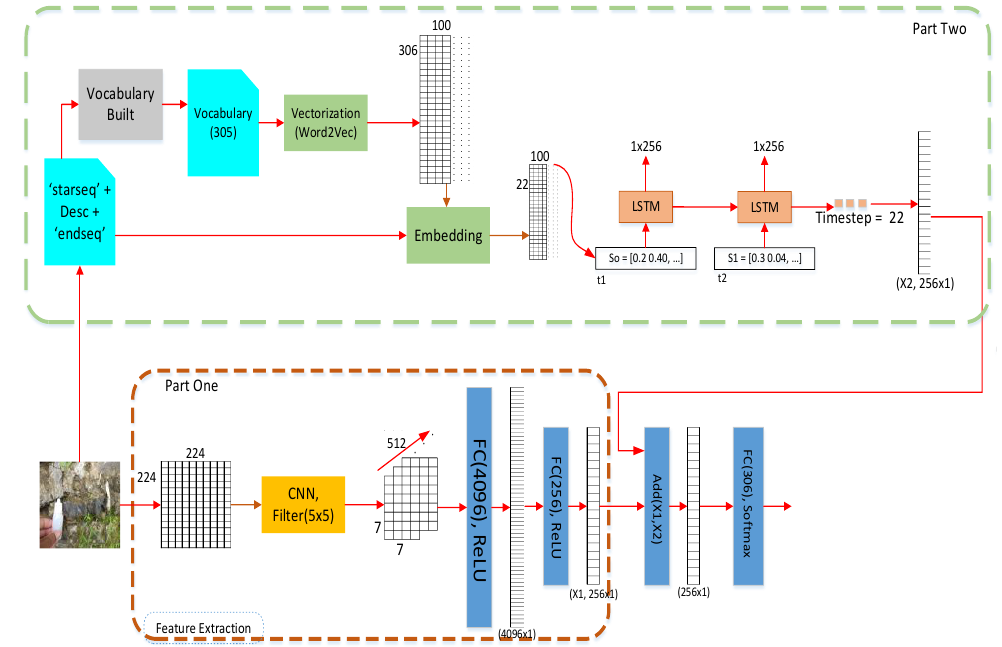
Figure 3. Proposed deep learning architecture (CNN: convolutional neural network, LSTM: long short-term memory).